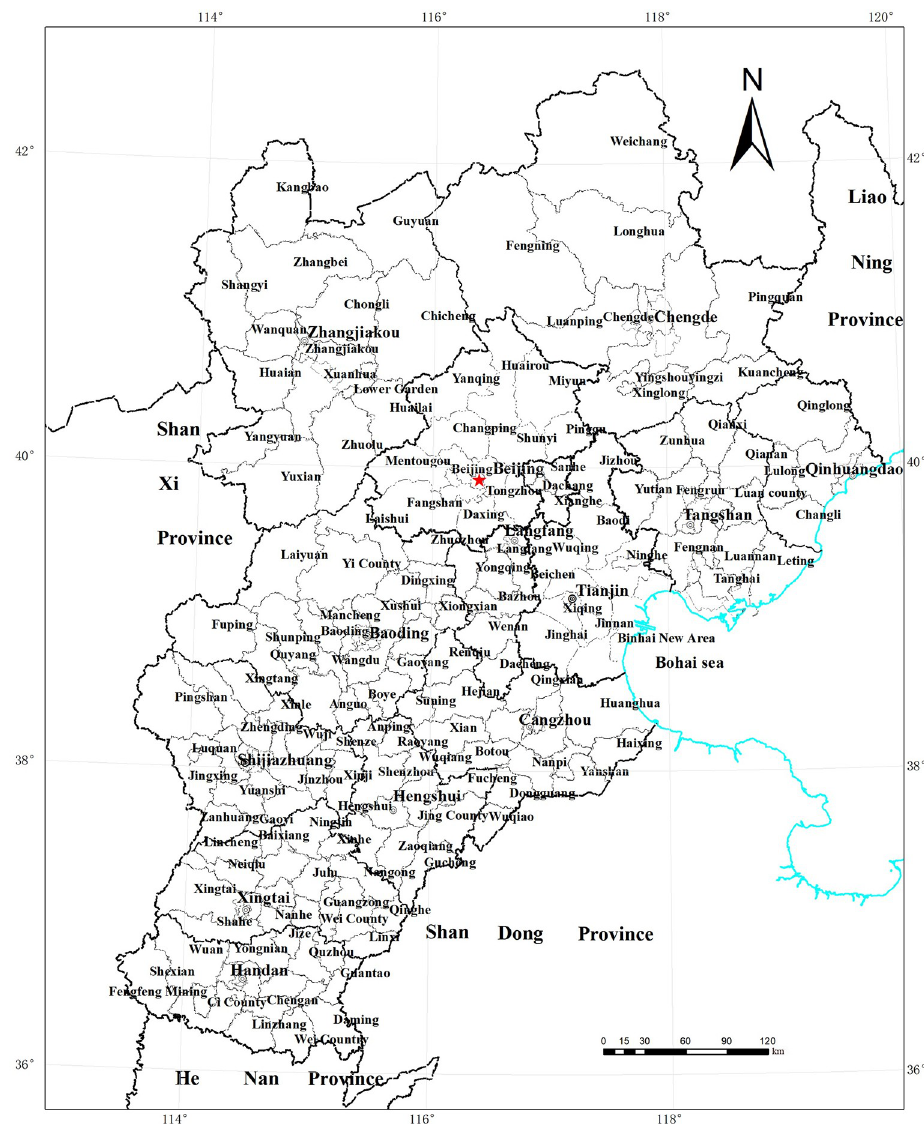
Fig 1. Location map of the Beijing-Tianjin-Hebei